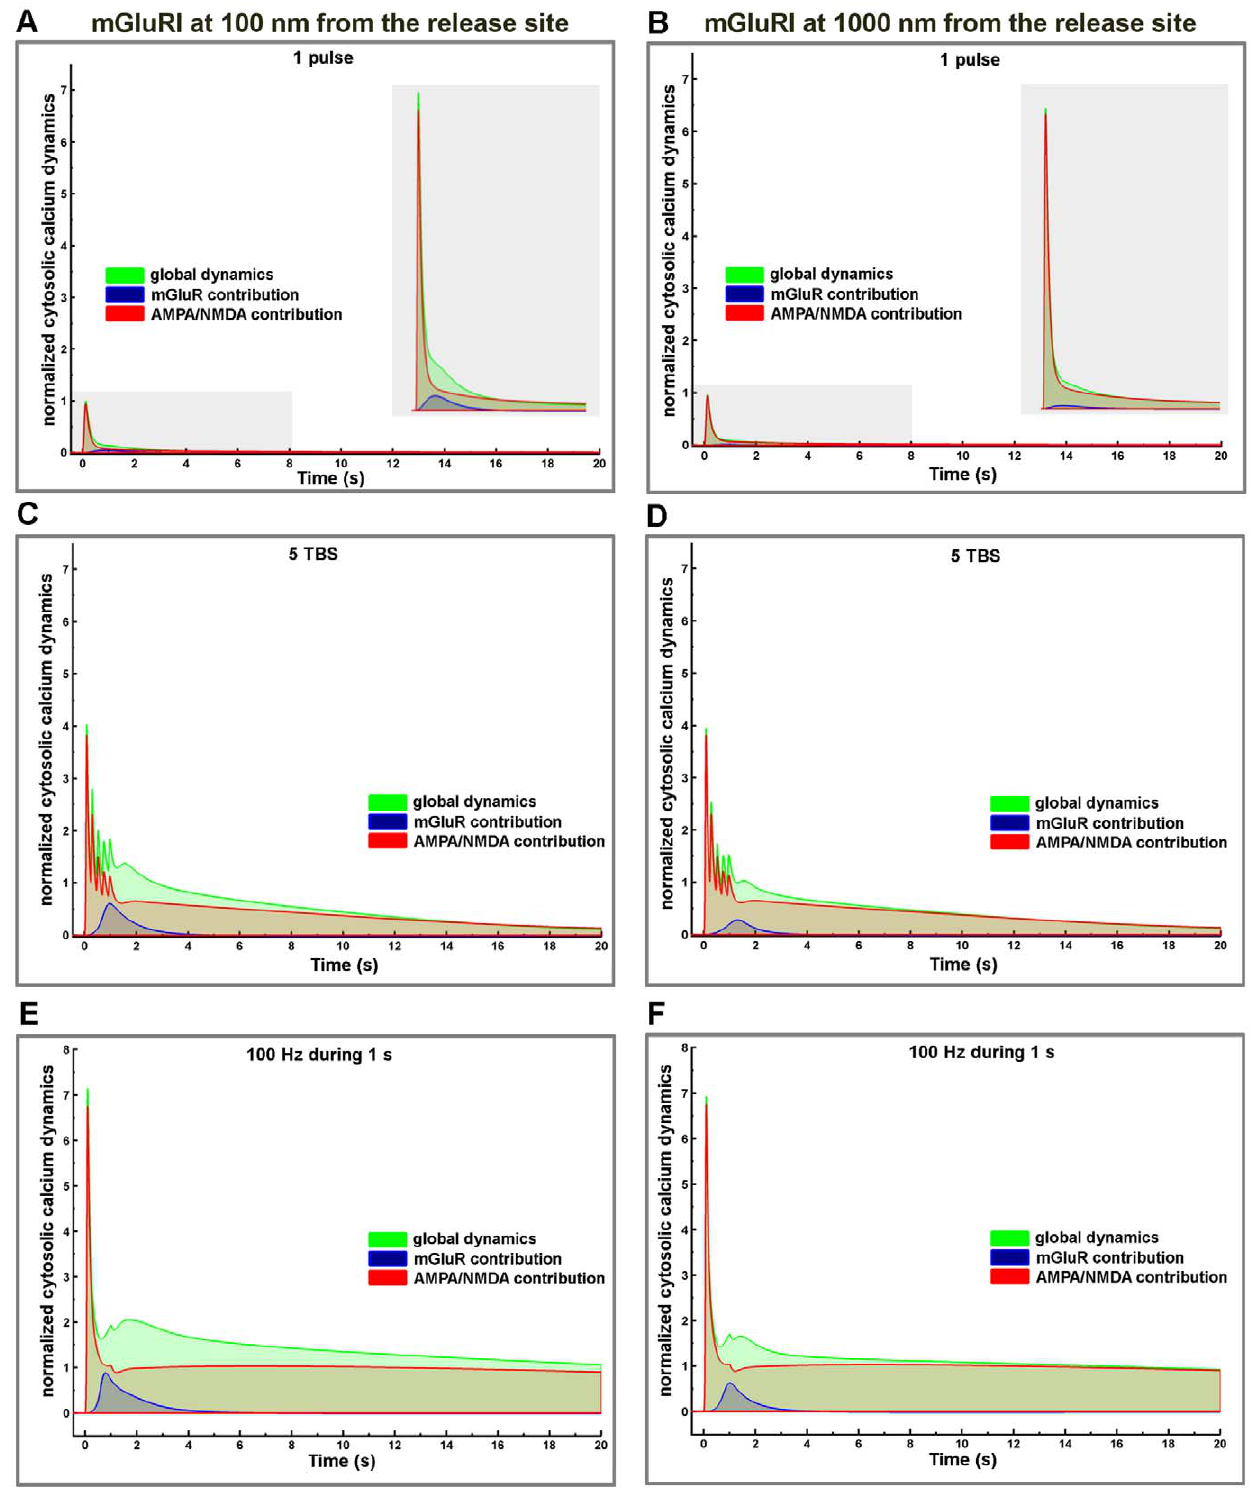
Figure 9. Respective contribution of ionotropic and metabotropic glutamate receptors on calcium cytosolic dynamics for different stimulation patterns and mGluRI locations. Temporal evolution of cytosolic calcium concentration dynamics (total response, green lines) generated by activation of ionotropic glutamate receptors (AMPA/NMDA, red lines) and mGluRI (blue lines) in response to one release event (A, B), 5 TBS (C,D) or 100 Hz during 1 s (E, F) with mGluRI located at 100 nm (A, C, E) or 1000 nm (B, D, F) from the release site. Values were normalized to the peak amplitude of the calcium response produced by AMPA, NMDA and mGluRI receptors combined, following one release event with mGluRI located at 100 nm from the release site (516 nM).